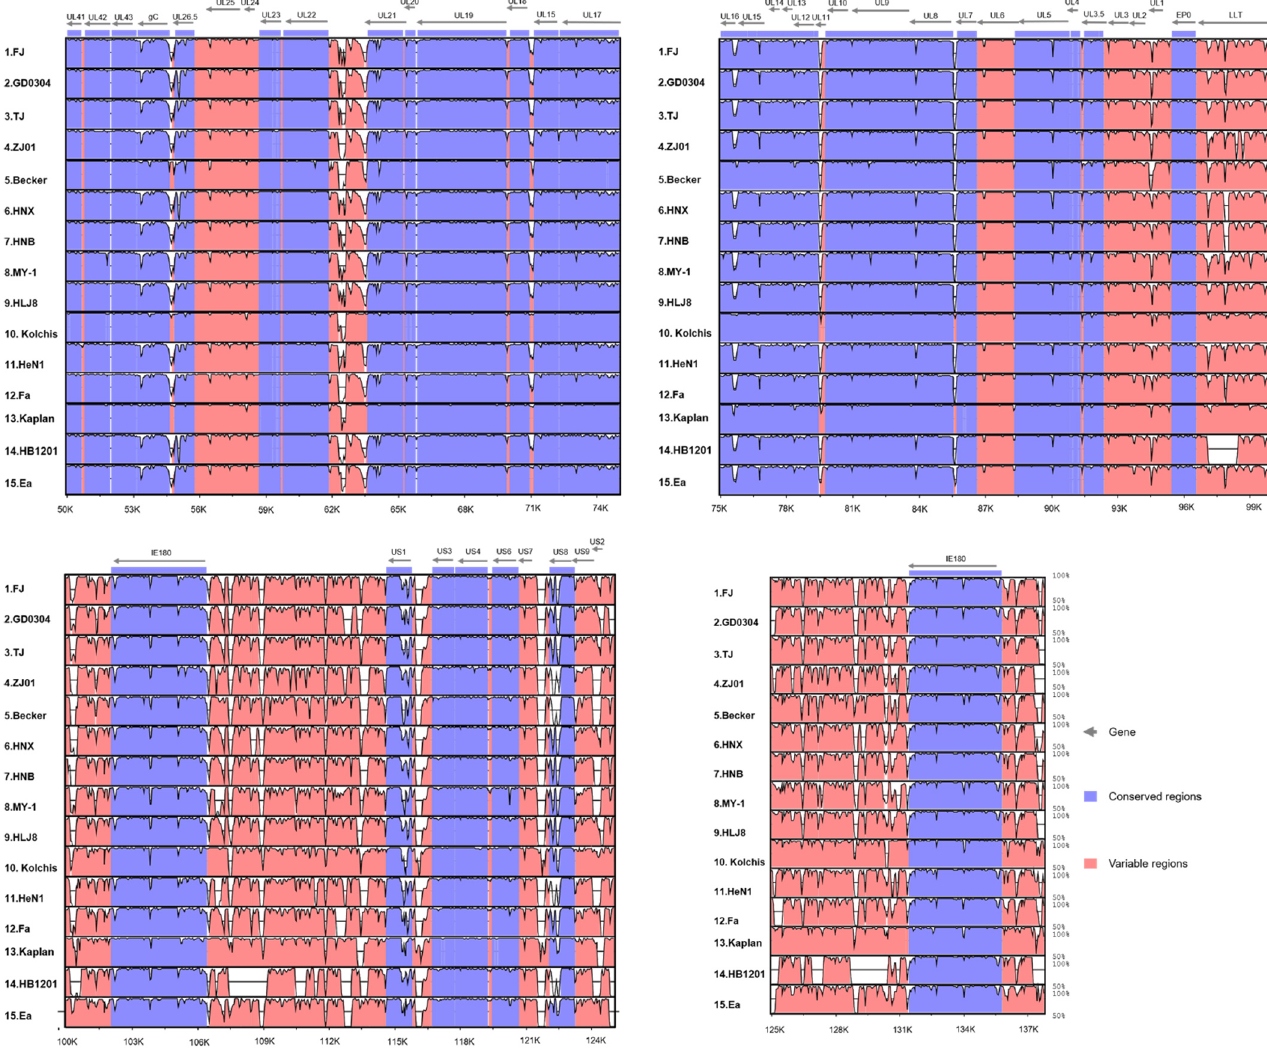
Figure 2. Genome organization and comparison of the PRV Bartha strain with the PRV FJ strain and the remaining 14 reference PRV strains. Comparison of the PRV genome shows conserved (blue) and variable (pink) regions. Open reading frames (ORFs) are represented by gray horizontal arrows across the top of each panel, and genome coordinates in kilobase pairs (kbp) are shown along the bottom.